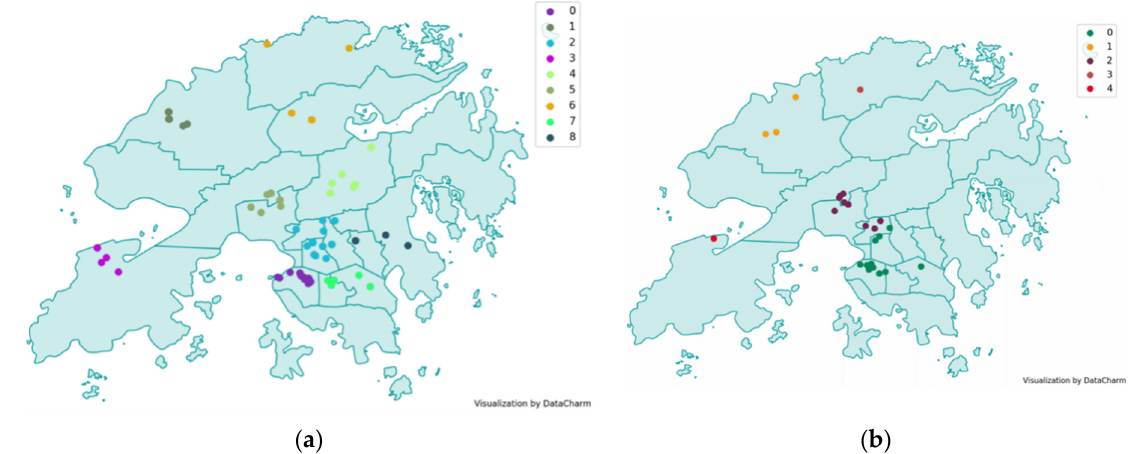
Figure 5. Clustering analysis results from 30 July 2019 to 5 August 2019: ( a ) is the clustering result of the Lihkg dataset; ( b ) is the result of the Twitter dataset. Table 4. Some entities with relatively high frequency in each cluster. Cluster